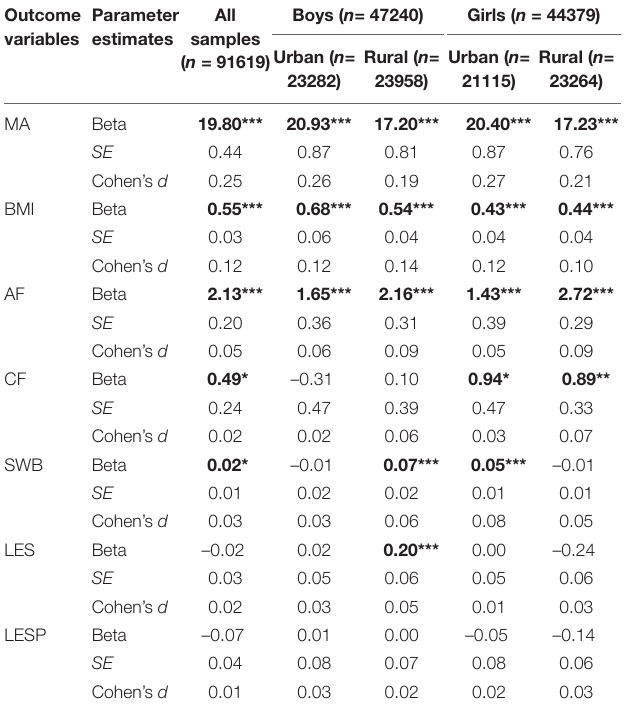
TABLE 3.2 | The differences of OC and NOC using SM. Outcome Parameter variables